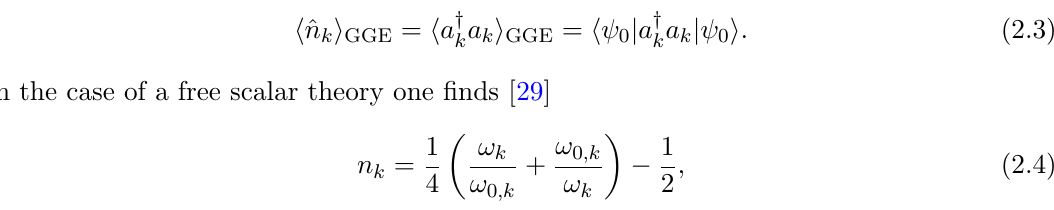
Figure 2 . Alba-Calabrese quasi-particle picture for a relativistic free boson and three distinct modes together with the zero mode. The saturation time for each mode is shown with f t (cid:3) time with regard to its group velocity given by ‘= (2 v g ). The saturation time of each mode (for a single interval) is by de(cid:12)nition the point where the corresponding rays